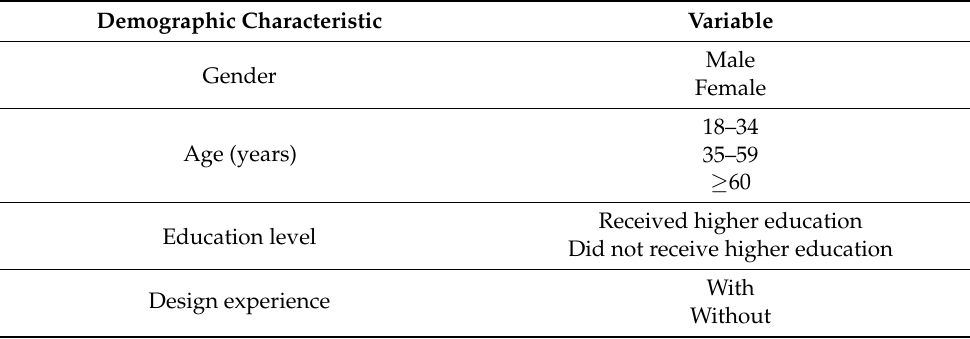
Table 3. Classification of demographic characteristics of surveyed respondents.